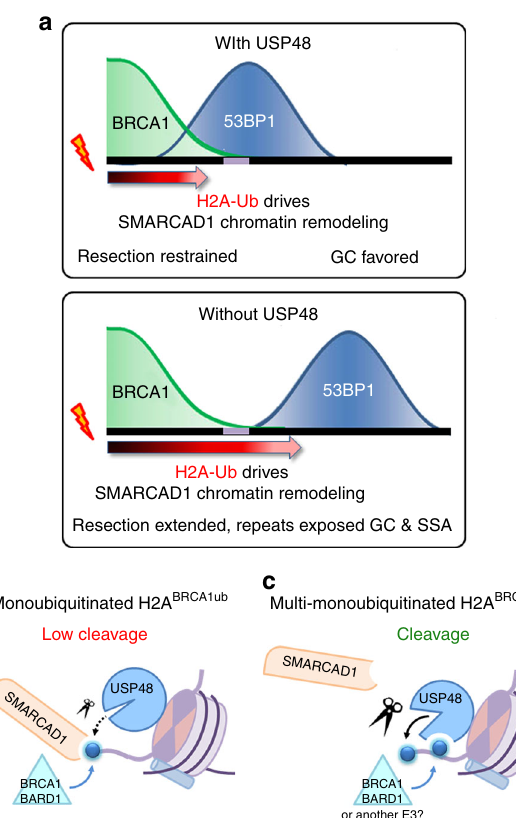
Fig. 6 Model of USP48 function in restricting extended DNA end resection. a USP48 cleaves the C-terminal ubiquitin modi fi cation of H2A, limiting the extent of SMARCAD1 nucleosome remodeling and 53BP1